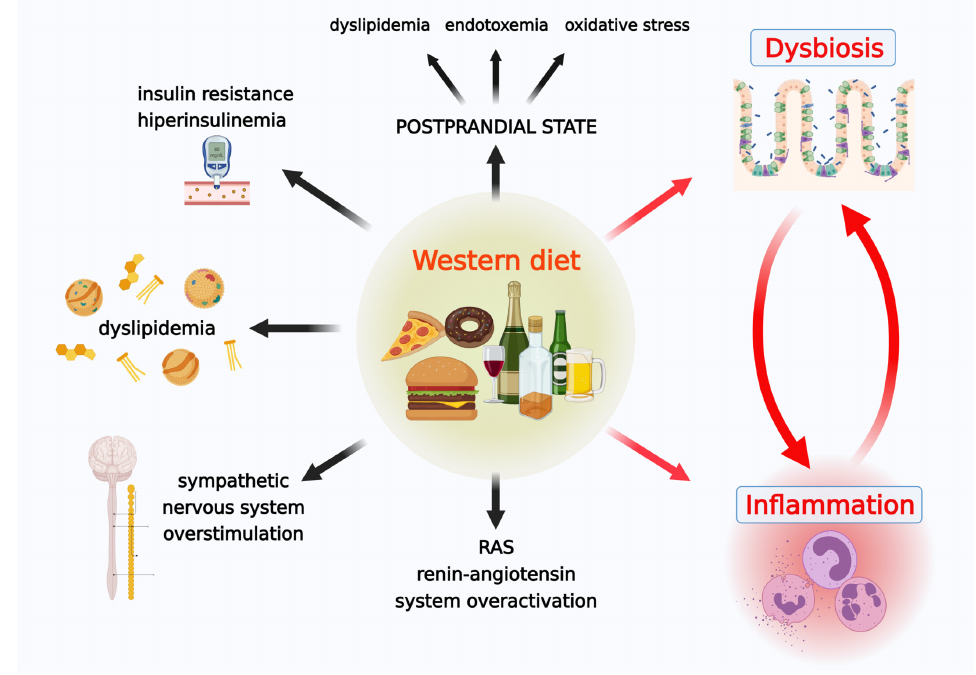
Figure 1. Western diet-associated pathologies.